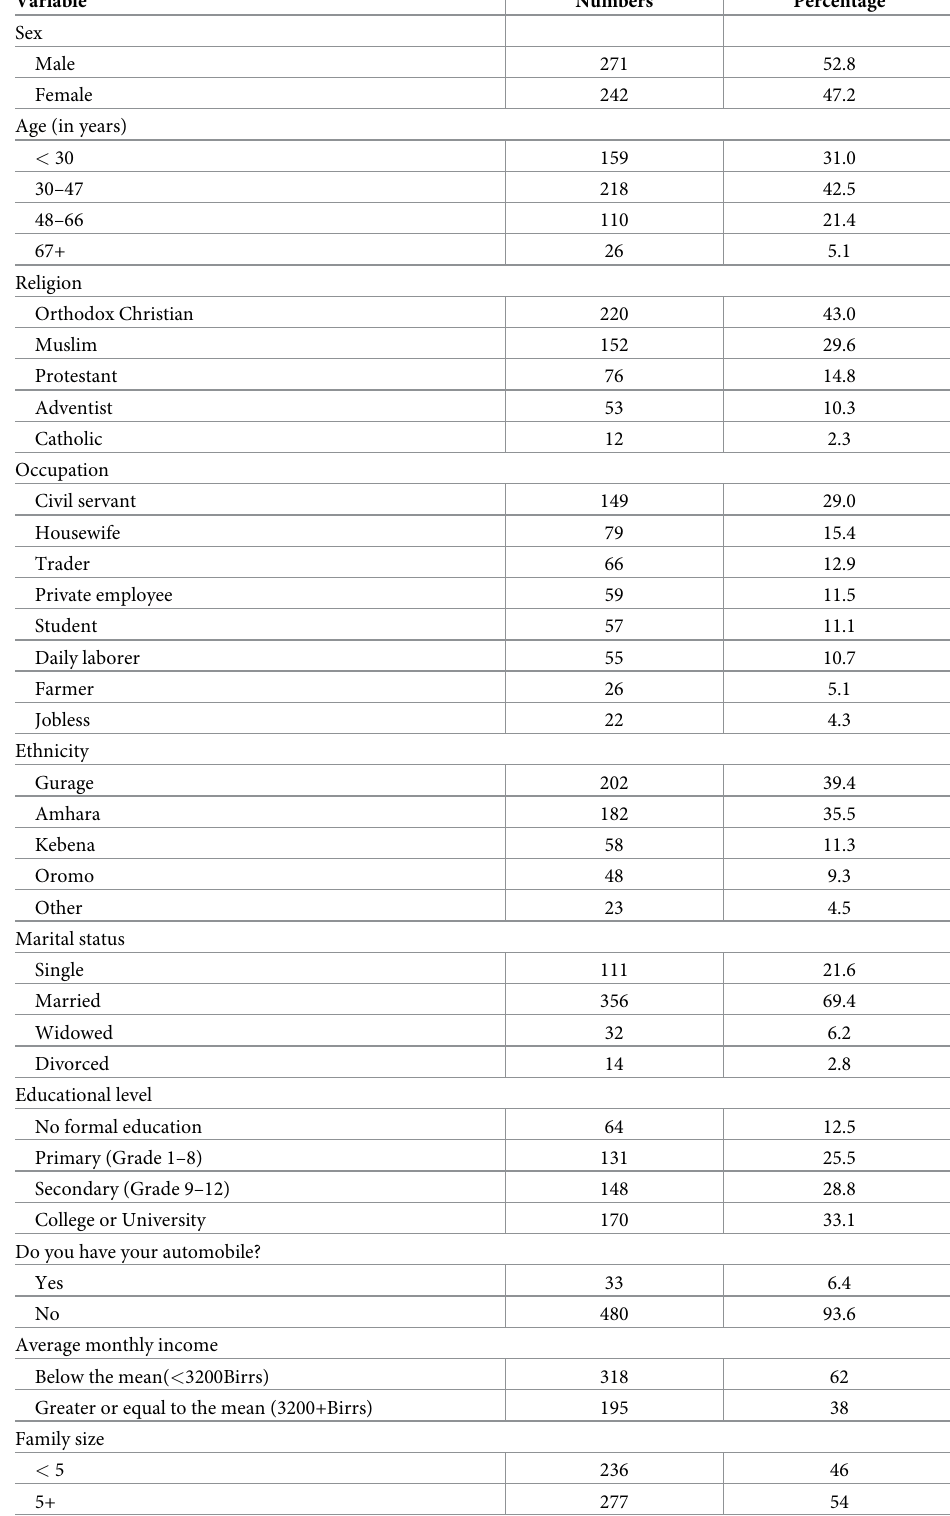
Table 2. Sociodemographic characteristics of the study participants (n =